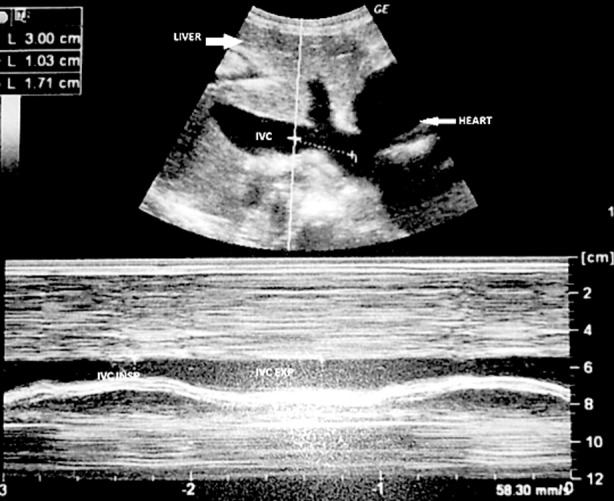
Ultrasonographic determination of inspiratory inferior vena cava (IVCinsp) and expiratory inferior vena cava (IVCexp).